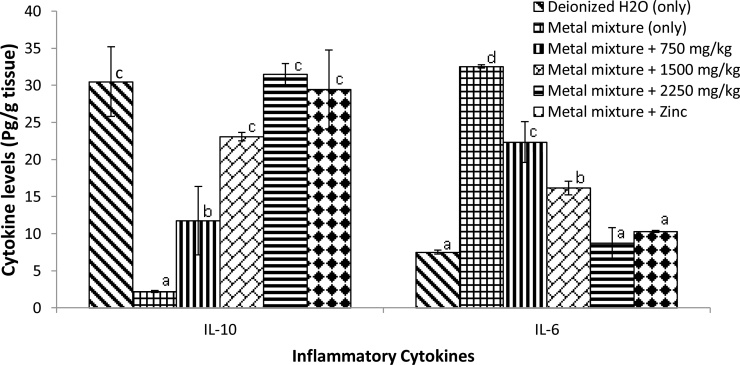
Effects of Costus afer and zinc on inflammatory cytokines (interlukin-10 (IL-10) and interlukin-6 (IL-6) on brain of male albino rats treated with metal mixture. Values with different superscripts (a, b, c) were significantly different from each other (p <  0.05) and those with the same superscripts were not significantly different.